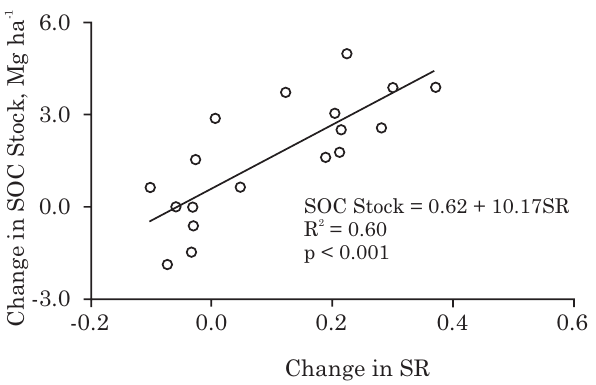
Figure 5. Relation between the change in the stratification ratio (SR) and the change in the SOC stock in the period of 160 days of oat residue